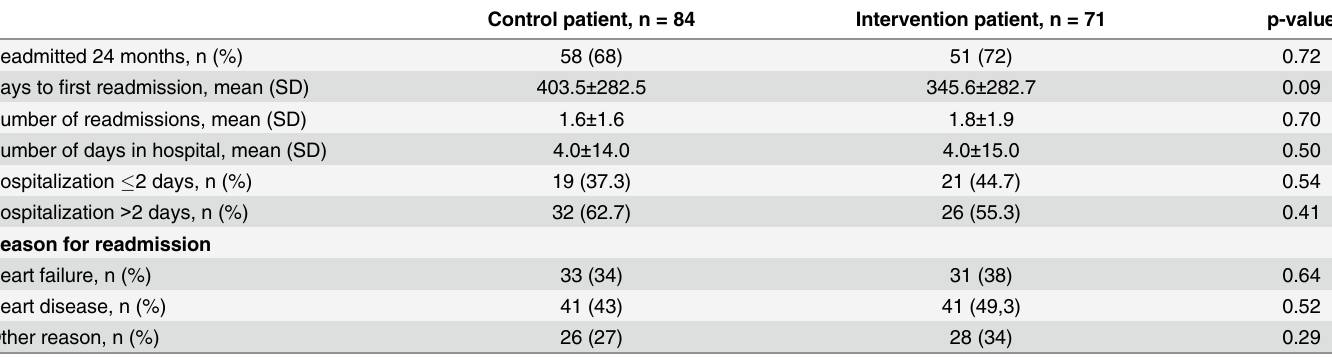
Table 3. Readmissions and reason for readmissions during the 24- month ’ s follow-up period.